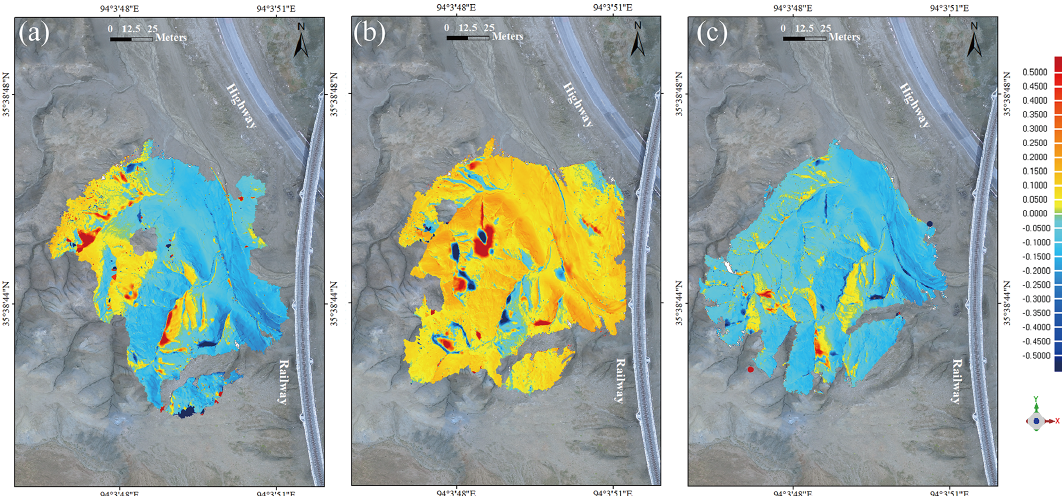
Figure 7. Deformation of slope B during the first thaw, first freeze, and second thaw: (a) first thaw, (b) first freeze, and (c) second